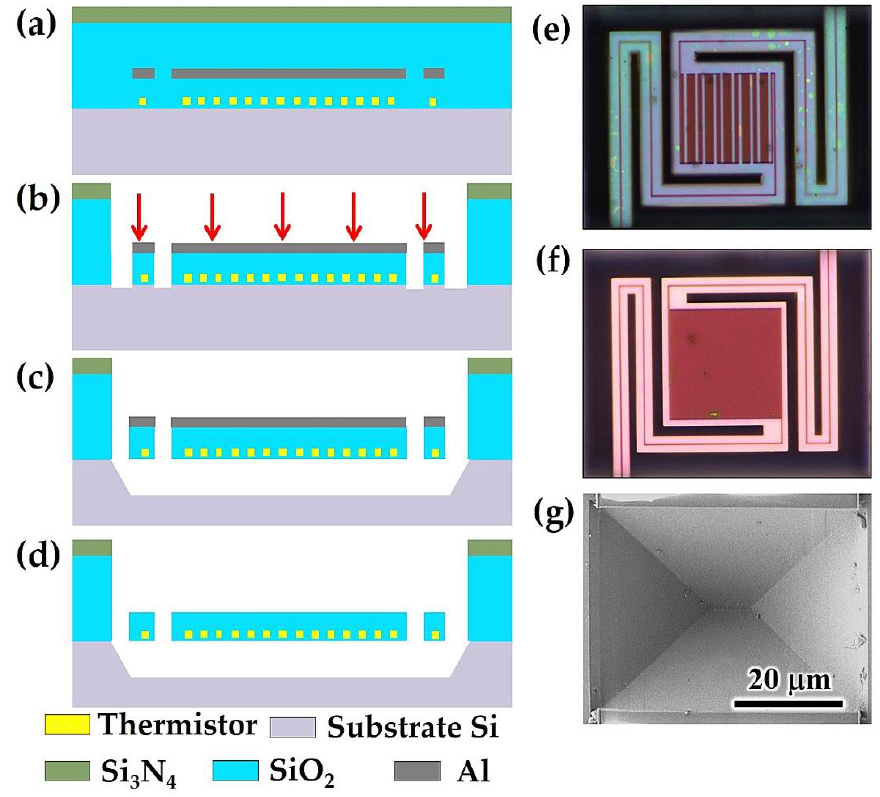
Figure 3. The fabrication processes and images of the proposed IR sensor, ( a ) the CMOS chip prepared by a standard 0.18 μm CMOS processes, ( b ) Si 3 N 4 and SiO 2 dry etching by ICP using the C 4 F 8 gas, ( c ) the Si substrate wet etching using the TMAH solution with Si powder and (NH4) 2 S 2 O 8 to suspend the detector structure for thermal isolated, and ( d ) the metal Al mask layer etching using the mixture of BCl 3 and Ar gases, the suspended ( e ) salicide polysilicon microbolometer and ( f ) metal Al microbolometer after post-COMS process, ( g ) the thermally isolated cavity at the bottom of the microbolometer that separated from the Si substrate.